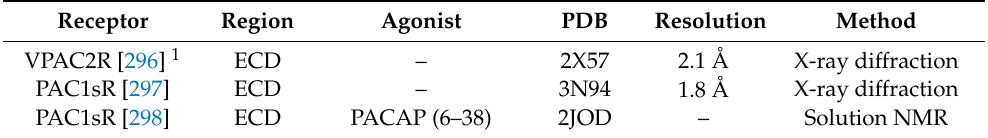
Table 5. List of structures of the ECD region of the PACAP subfamily of receptors determined through X-ray crystallography and